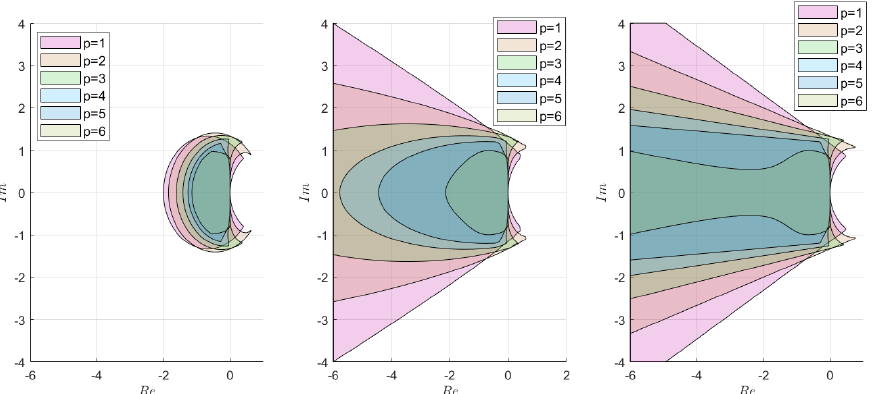
Figure 2. Stability regions of Adams–Bashforth–BDF semi-implicit methods with k = [ 0,0.5,1 ] (from left to right).